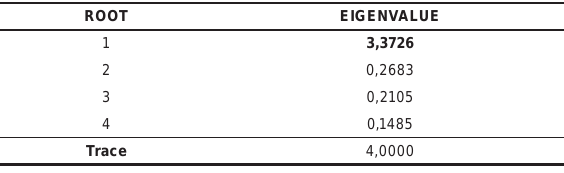
TAbLE 4 Eigenvalues of unreduced intercorrelation matrix